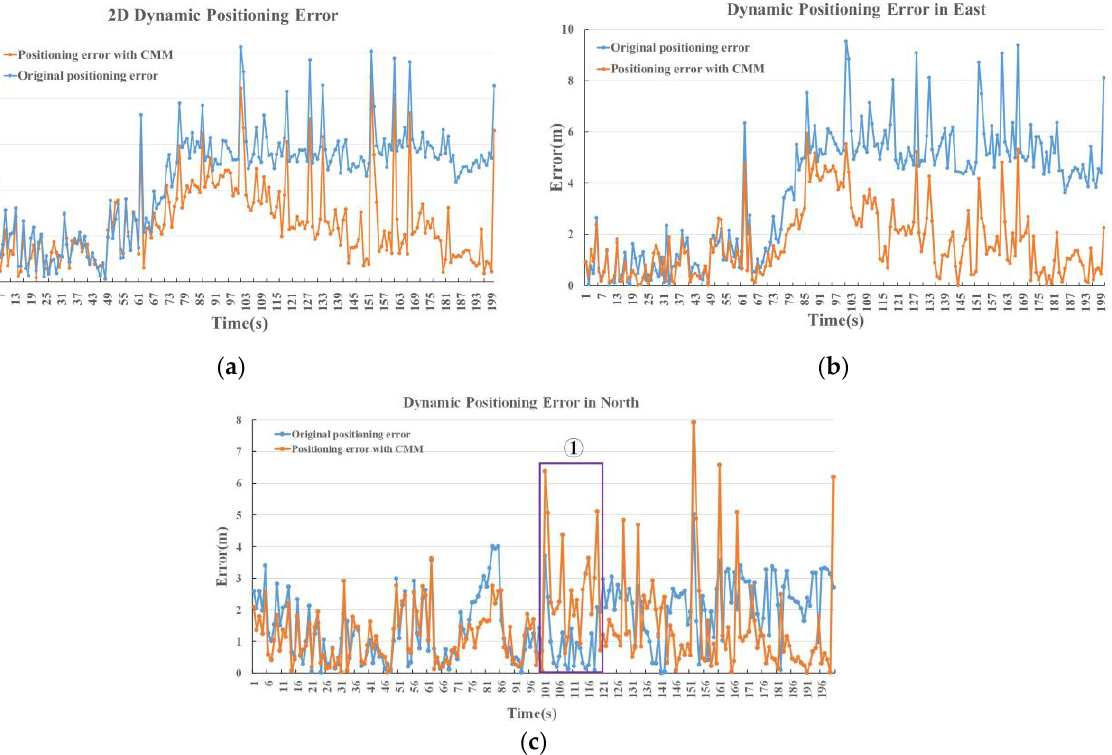
Figure 10. Dynamic experimental results. ( a ) 2D error; ( b ) eastward error; ( c ) northward error.